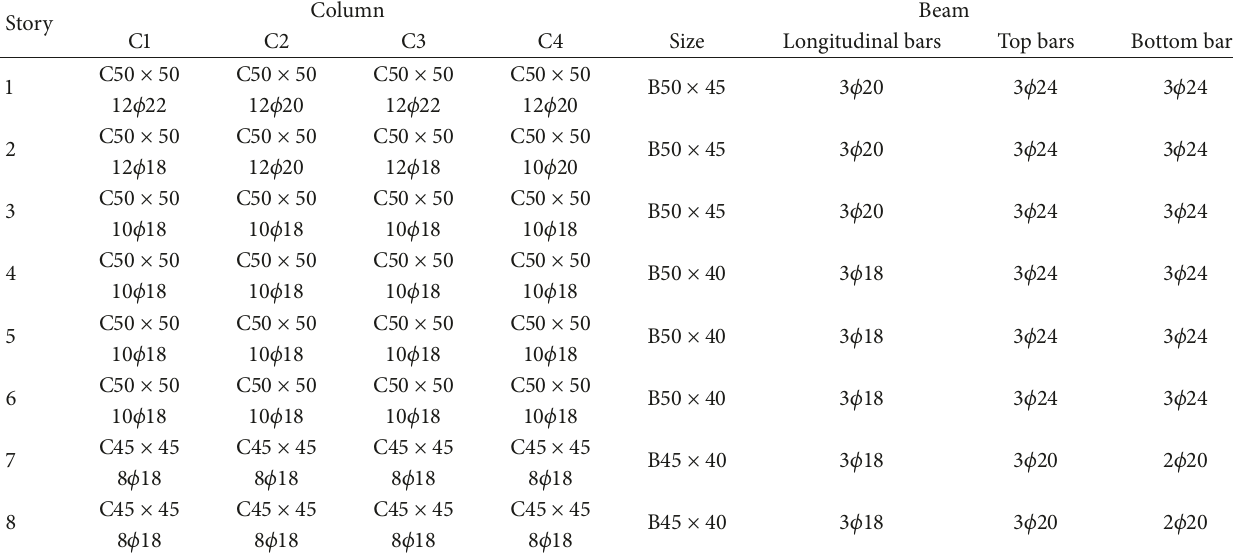
Table 6: Sections for the 8-story RC